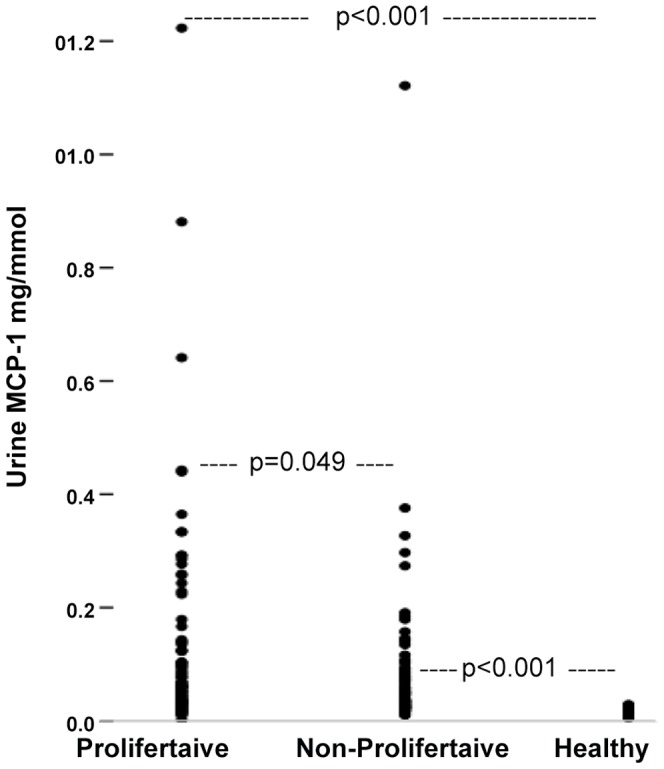
The urine concentrations of MCP-1 in proliferative and non-proliferative forms of glomerulonephritis compared to the urine concentrations of MCP-1 in healthy individuals, p<0.001 with Bonferroni-Holm corrections.